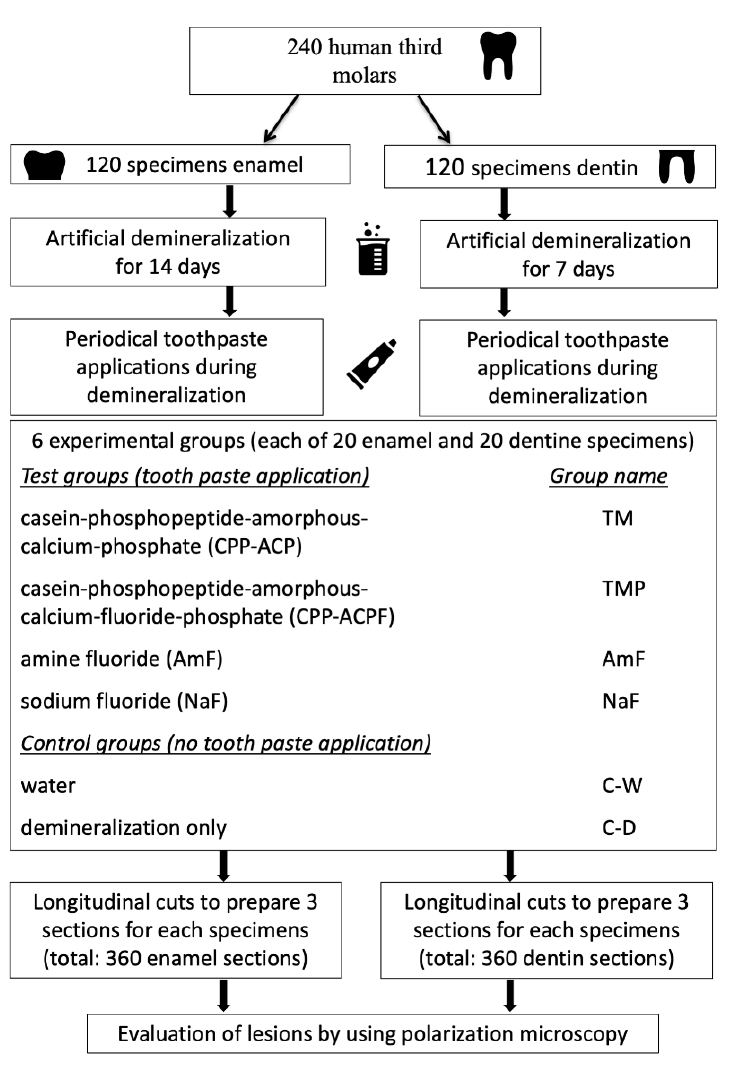
Figure 1. Schematic overview illustrating the experimental procedure of this study.